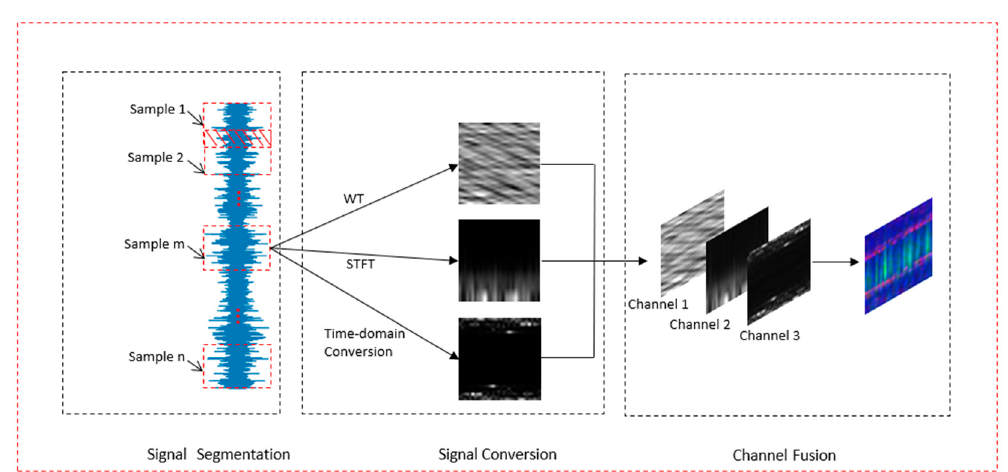
Figure 2. Three-channel RGB vibration image conversion process.